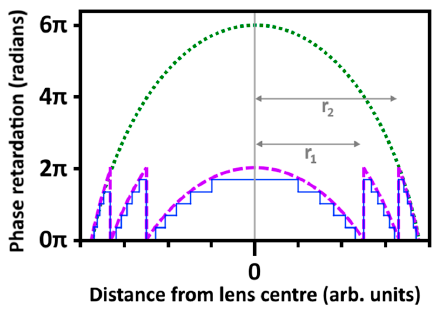
Figure 13. Plot demonstrating the relationship between the phase retardation of light passing through the lens with respect to its distance from the center. The green dotted line indicates the refractive profile, the purple dashed line is the kinoform profile, and the solid blue line is a multi-level diffractive profile [6].